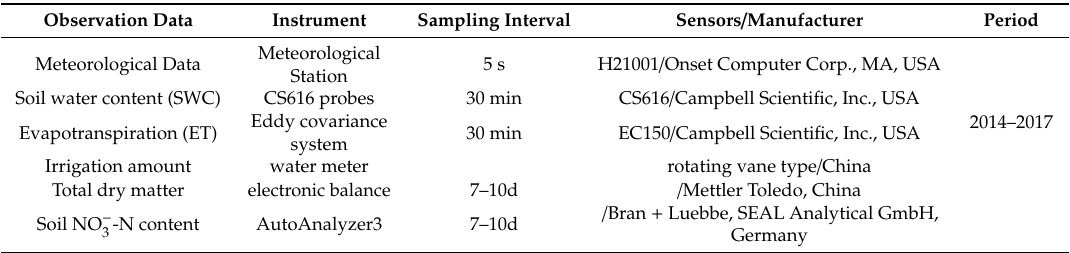
Table 2. Field observation